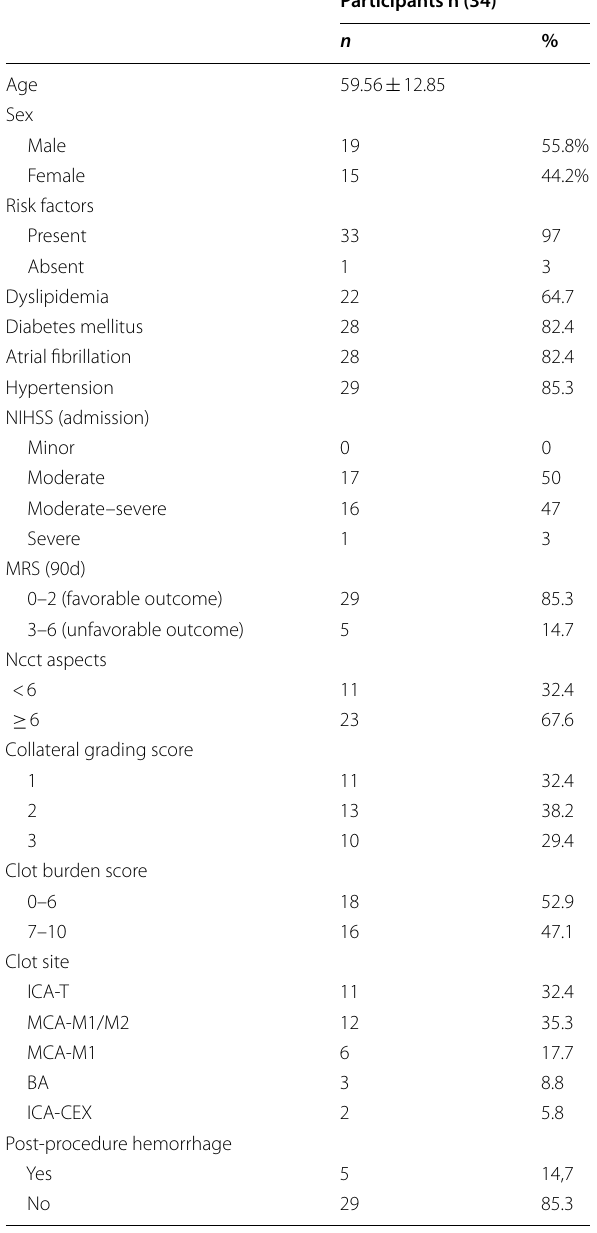
Table 1 Baseline clinical and demographic characteristics of patients ( n =